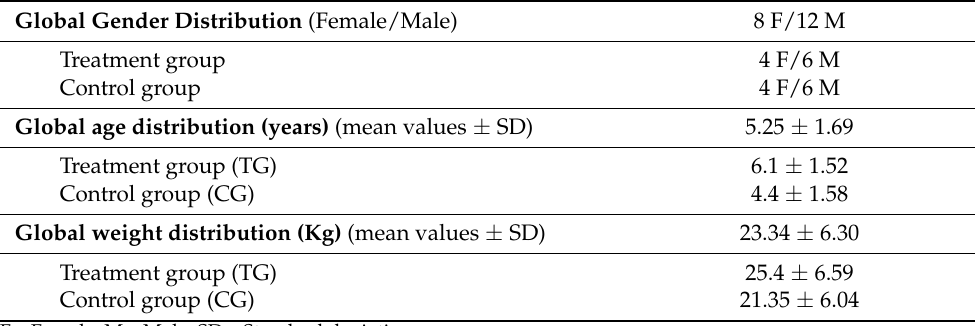
F—Female; M—Male; SD—Standard